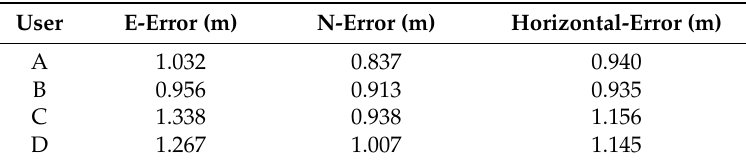
Table 9. The result of space resection for the HTC in a real